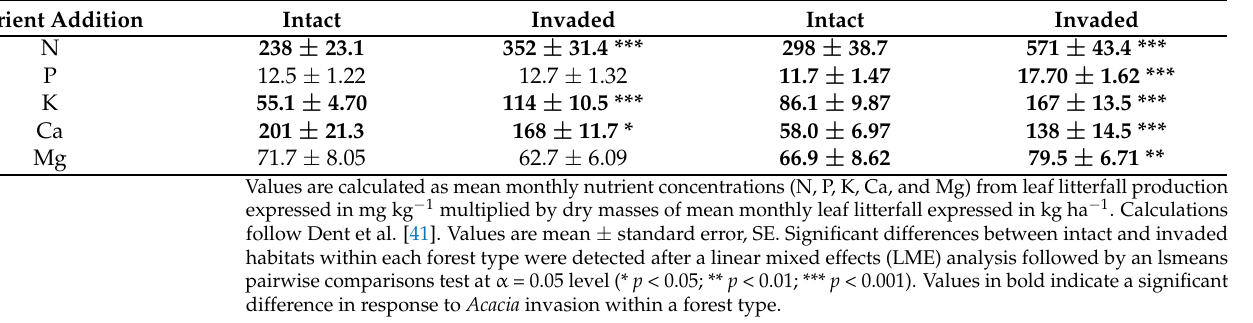
Table 3. Estimated nutrient addition (kg ha − 1 yr − 1 ) from leaf litterfall production from 24 litterfall traps in four habitat types (intact and Acacia -invaded heath forest and intact and Acacia -invaded mixed dipterocarp forest) over a 12-month period (October 2016–September 2017). Heath Forest Mixed Dipterocarp